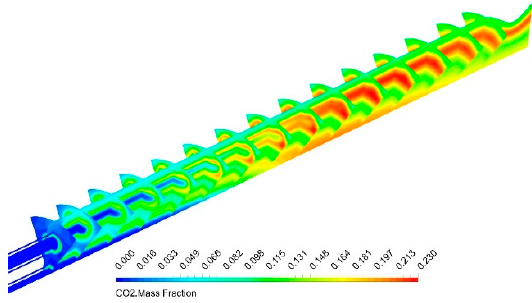
Figure 17. The CO 2 mass fraction field (50% axial Figure 17. The CO (cid:2870) mass fraction field (50% axial scaling). Figure 17. The CO (cid:2870) mass fraction field (50% axial scaling).